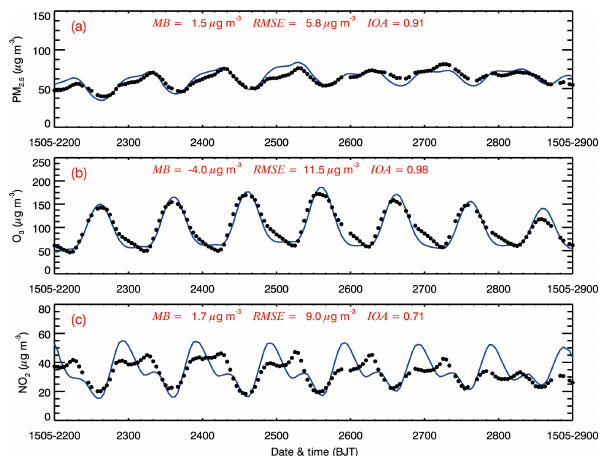
Figure 5. Comparison of measured (black dots) and predicted (blue line) diurnal profiles of near-surface hourly (a) PM 2 . 5 , (b) O 3 , and (c) NO 2 averaged over all ambient monitoring stations in northern China from 22 to 28 May 2015.